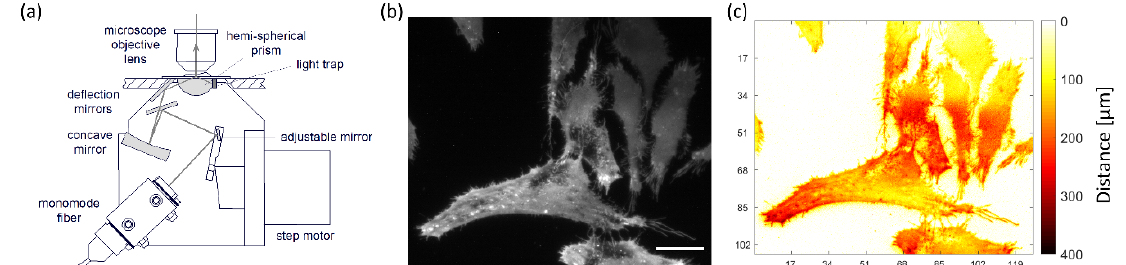
Photonics 2021 , 8 , 176 4 of 10 400 nm calculated from VA-TIRFM according to Equation (1) and shown by color code ( c ) (excitation wavelength: 476 nm,